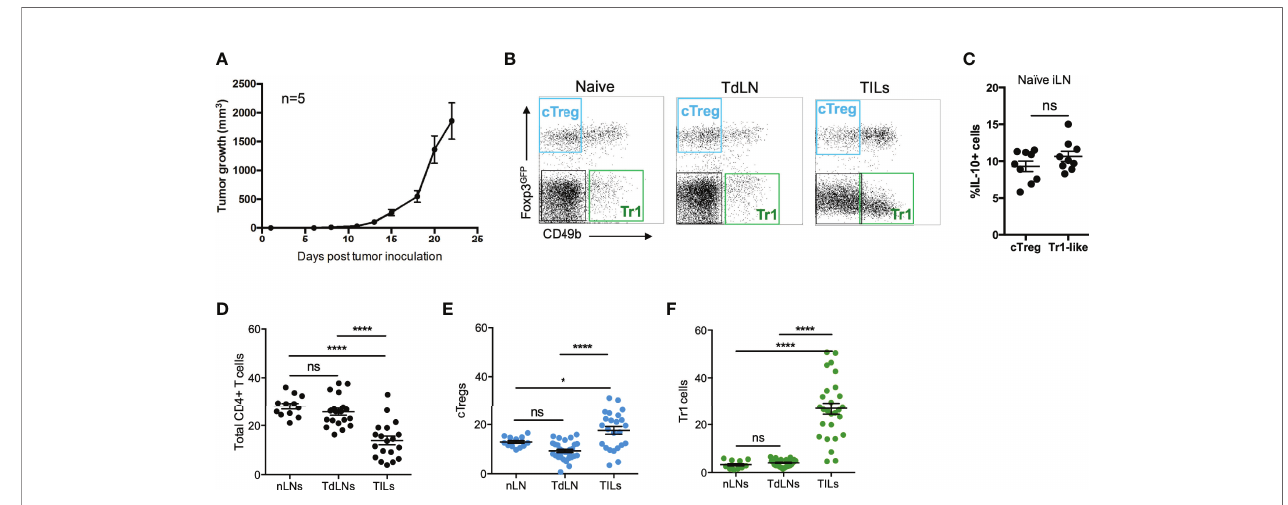
FIGURE 1 | Tr1 cells are more abundant at the tumor site than conventional Tregs. (A) A total of 2 × 10 5 B16 cells were injected into the right fl ank of C57BL6 GFP reporter mice, and tumor growth was monitored and measured every other day. Between day 18 and 20 post-inoculation, tumor-draining lymph nodes (TdLNs) and tumor-in fi ltrating lymphocytes (TILs) were collected for fl ow cytometry analysis. (B) Representative dot plots from naive inguinal lymph nodes (nLNs), tumor draining lymph nodes (TdLNs), and tumor-in fi ltrating leukocytes (TILs) depicting the gating strategy for the study of conventional Treg cells (cTreg) considered as CD4 +Foxp3 GFP+ CD49b − T cells and Tr1 cells, considered as CD4+Foxp3 GFP − CD49b+ T cells. The frequencies of IL-10+ cells in cTreg and Tr1 cells subsets (C) , of total CD4+ T cells (D) , cTregs (E) , and Tr1-like cells (F) from naive and tumor-bearing mice are shown in the corresponding graphs. * p < 0.05; **** p < 0.0001 according to one-way ANOVA (multiple comparisons) for panels (D – F) and Mann – Whitney test for panel (C) ; ns, not signi fi cant. Mean ± SEM. n = 3 independent experiments with fi ve to eight mice per